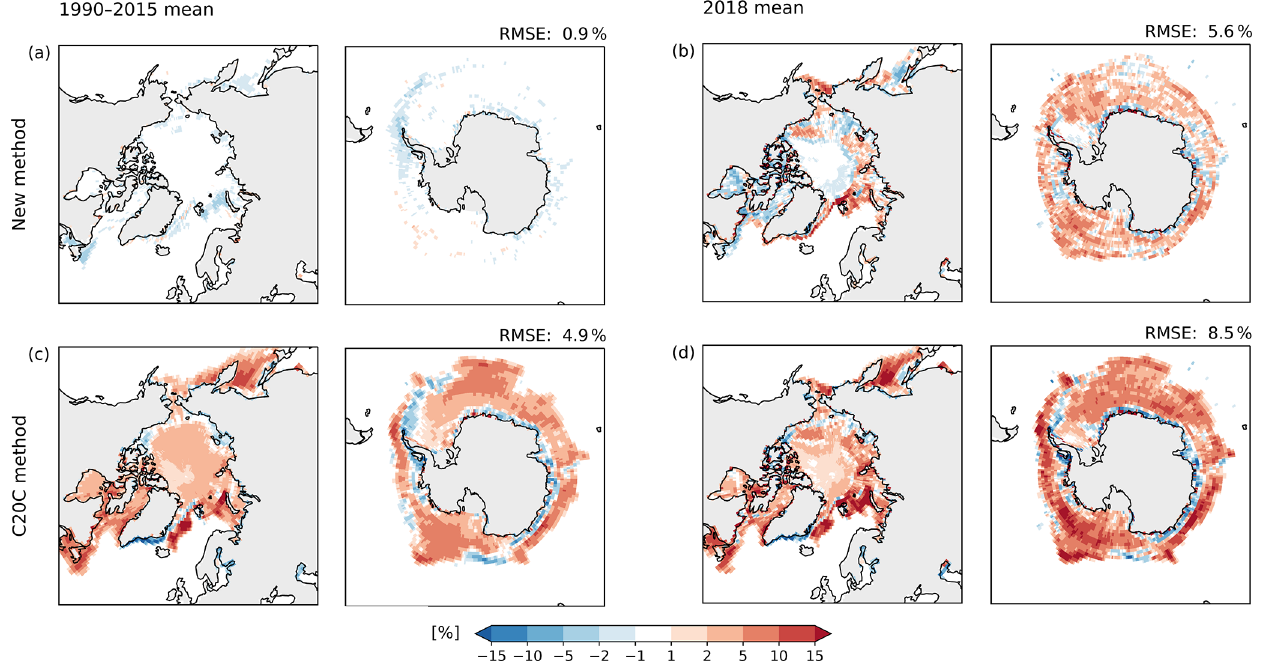
Figure A1. Evaluation of sea ice reconstruction. Shown is the bias (%) of reconstructed historical sea ice for the (a, c) 1990–2015 mean and (b, d) 2018 mean compared to NOAA OIv2 for areas north of 50 ◦ N and south of 50 ◦ S. The new method developed in this study (a, b) is compared to the C20C method (c, d) . Numbers in the upper right corner indicate the global mean RMSE for grid cells that are covered by ice in the observed or estimated fields.